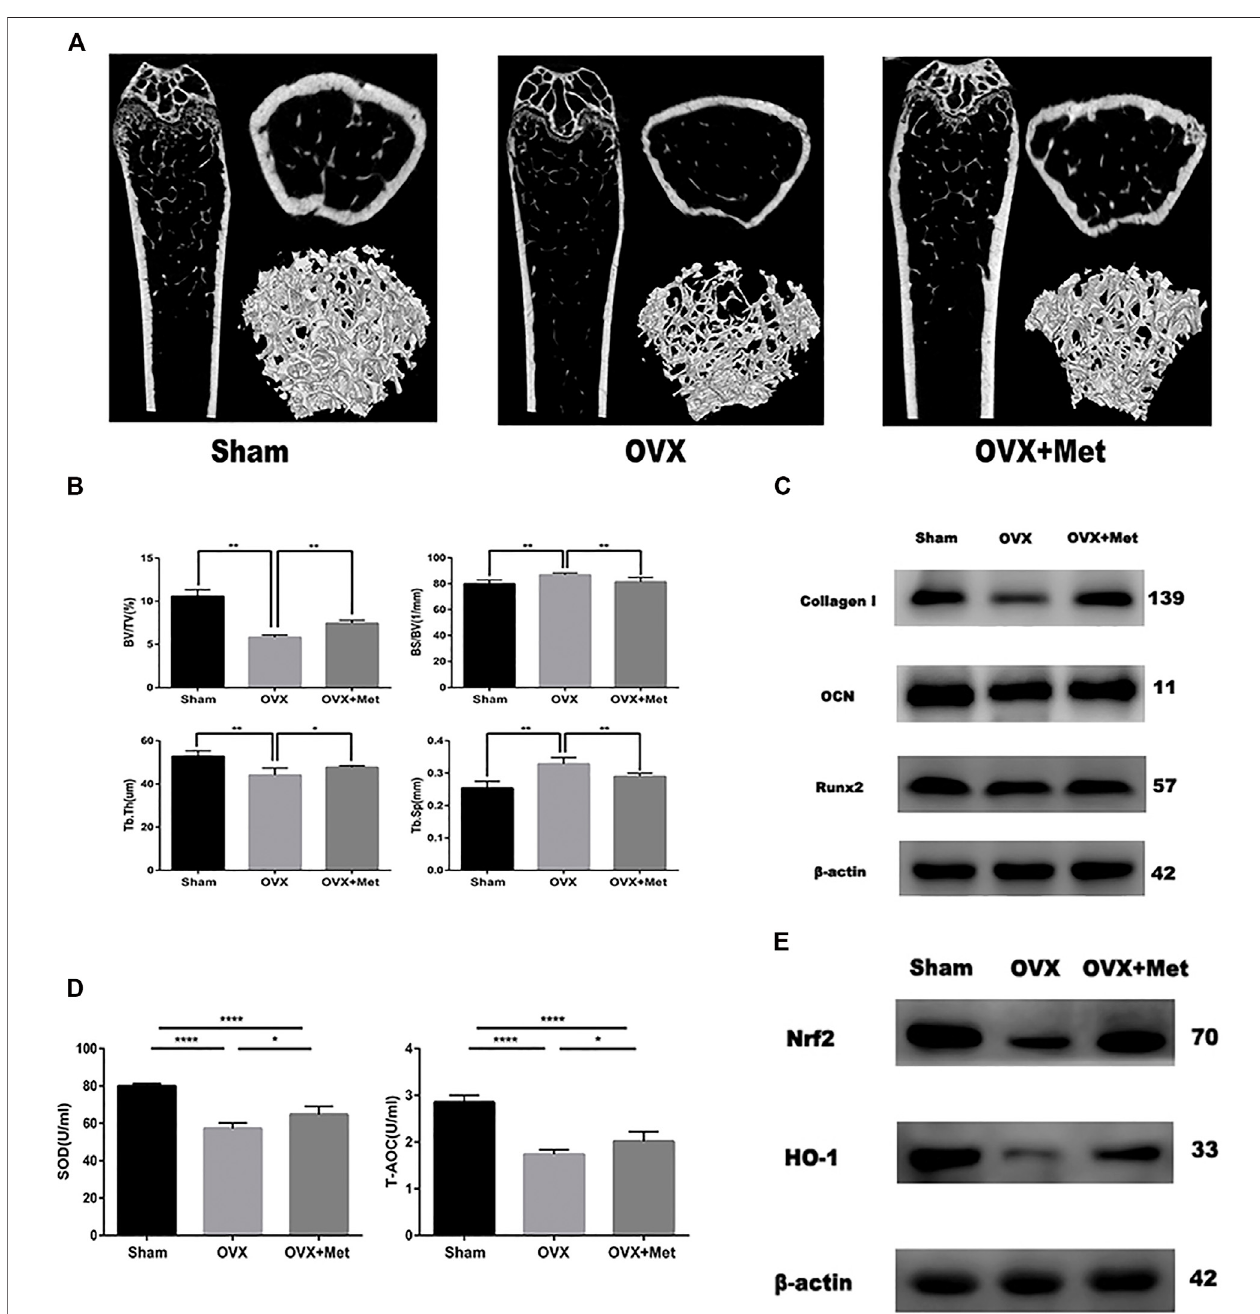
FIGURE 4 | Metformin reserved bone mass loss of OVX mice. (A) 2D and 3D reconstruction ofthe femur micro-CT images. (B) Related parameters obtained from imageanalysis (n =7 specimens/group). (C) Protein level of osteogenic markers Collagen I, Runx2 and OCN in femur samples. (D) Serum anti-oxidative level SOD1 and T-AOC in mice ( n = 5 specimens/group). (E) The protein expression of Nrf2 and HO-1 in bone tissue. Data are means ± SD, * p < 0.05, ** p < 0.01, *** p < 0.001, **** p < 0.0001 compared with OVX analyzed by using ANOVA.